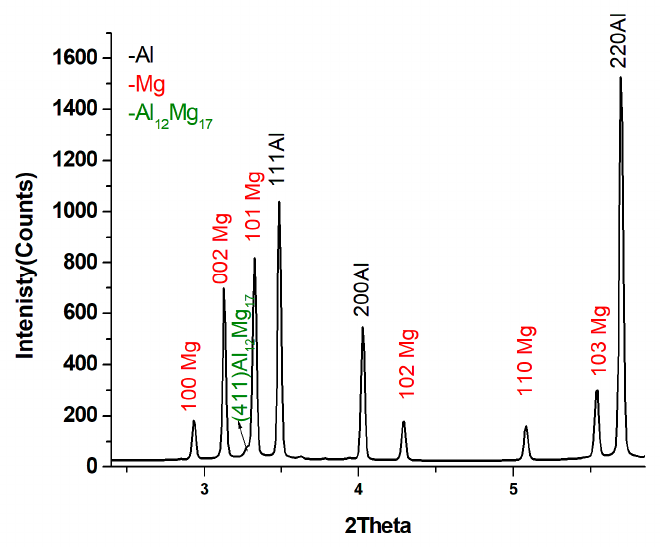
Figure 4. The synchrotron diffraction pattern of Al60Mg40.